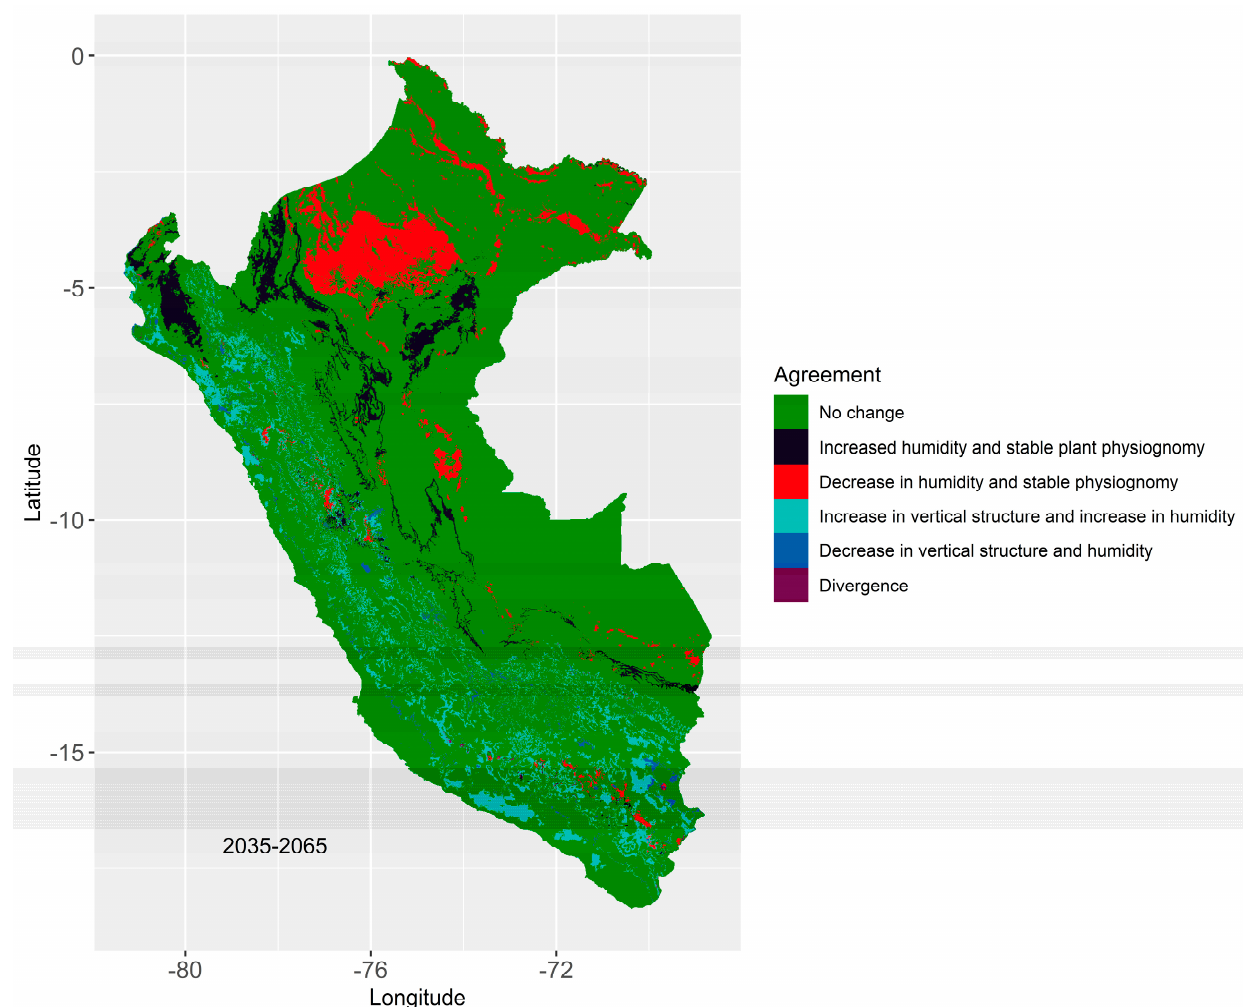
Figure 5. Concordance of biome projections with RF using different climate models for 2035–2065.